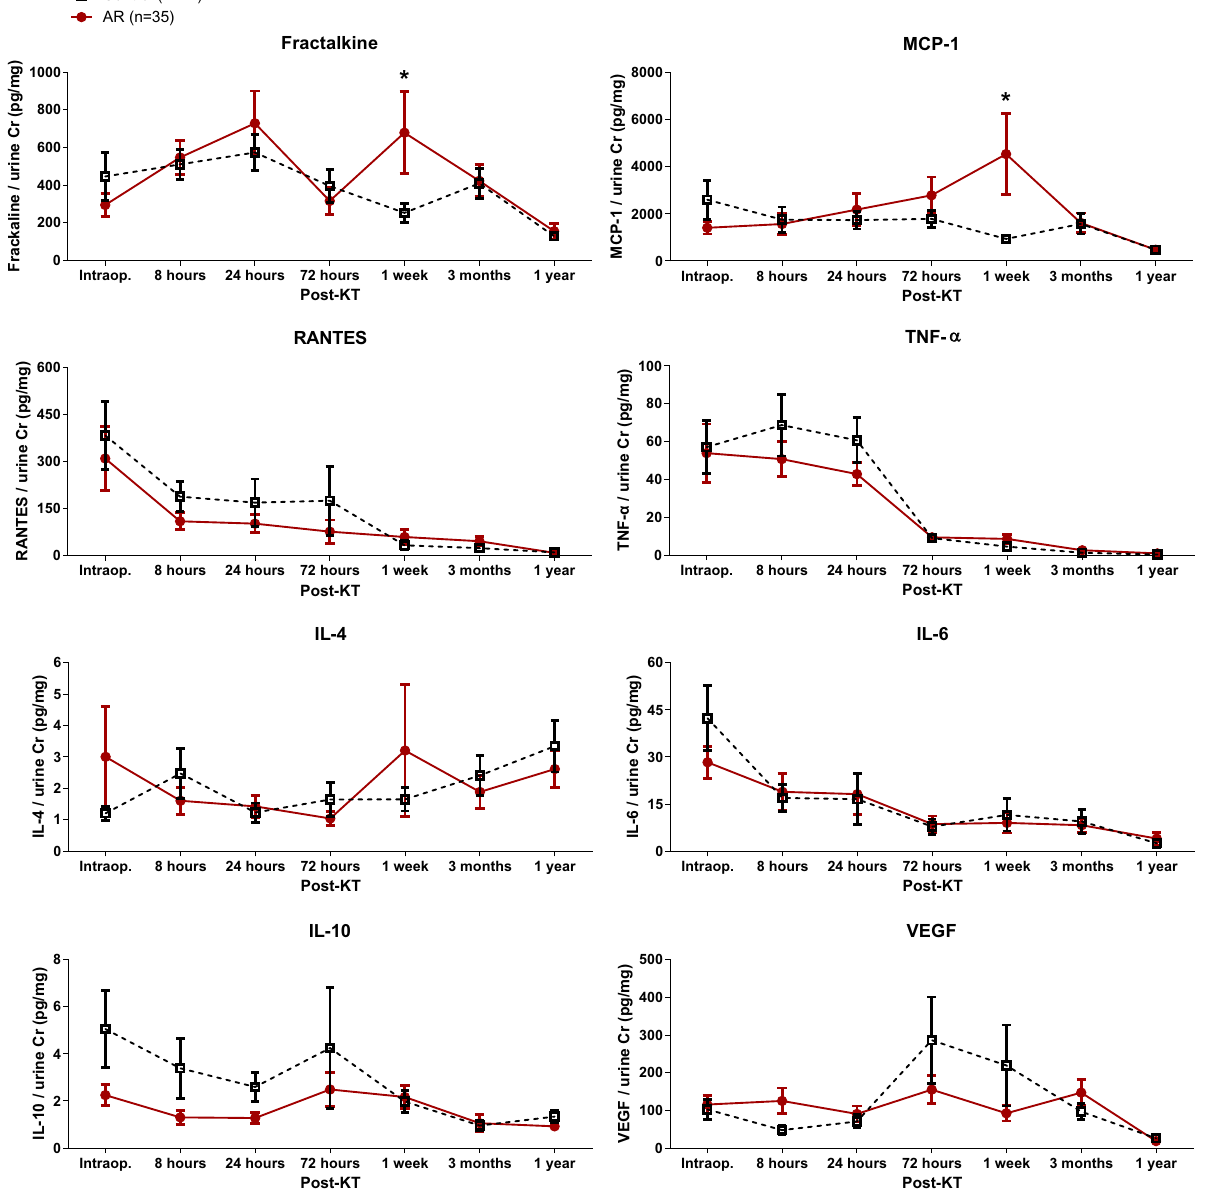
Figure 2. Urinary cytokines/chemokines of the control and AR groups. ( a ) Serial changes in urinary cytokines/ chemokines of the control and AR groups. Urinary MCP-1 at 1 week post-KT was significantly higher in the AR group. ( b ) Post-KT 1-week urinary cytokines/chemokines of the control and early AR (AR within 3 months) groups. The early AR group showed higher urinary fractalkine, MCP-1, RANTES, TNF-α, and IL-6 compared with the control group. * P < 0.05 compared with the control group. AR acute rejection, Cr creatinine, IL interleukin, KT kidney transplantation, MCP-1 monocyte chemoattractant protein-1, RANTES regulated on activation, normal T cell expressed and secreted, TNF-α tumor necrosis factor-α, VEGF vascular endothelial growth